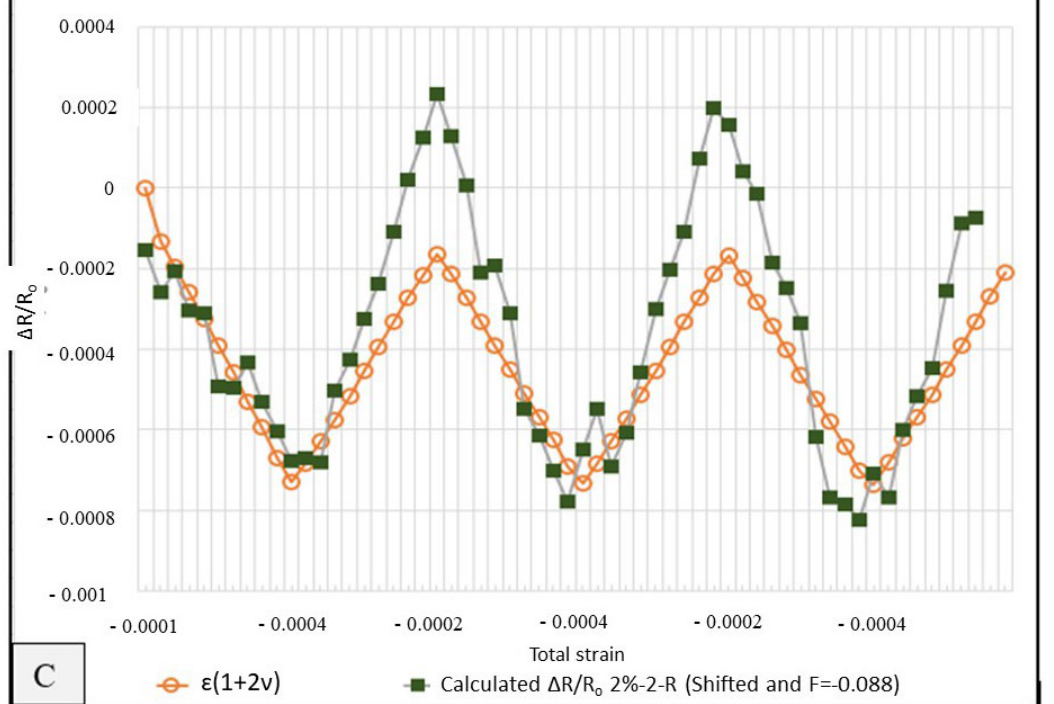
Figure 7. Strain and Resistance Measurements Time History for 2% Specimen Load Test 1: Left Electrode ( A ), Middle Electrode ( B ), and Right Electrode ( C ).